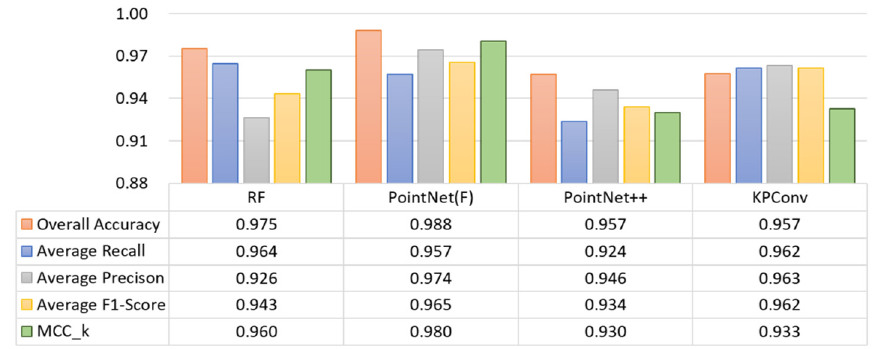
Figure 10. Comparison of classification results on ALS point clouds using RF and three deep learning models.